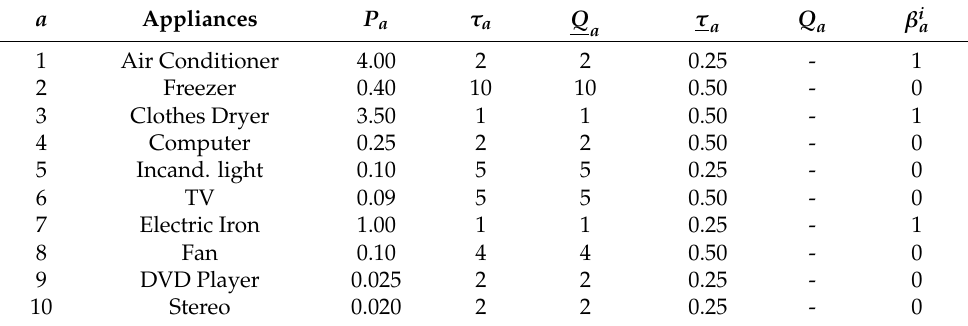
Table 1. Technical Data related to Home Appliances with β a = 1.